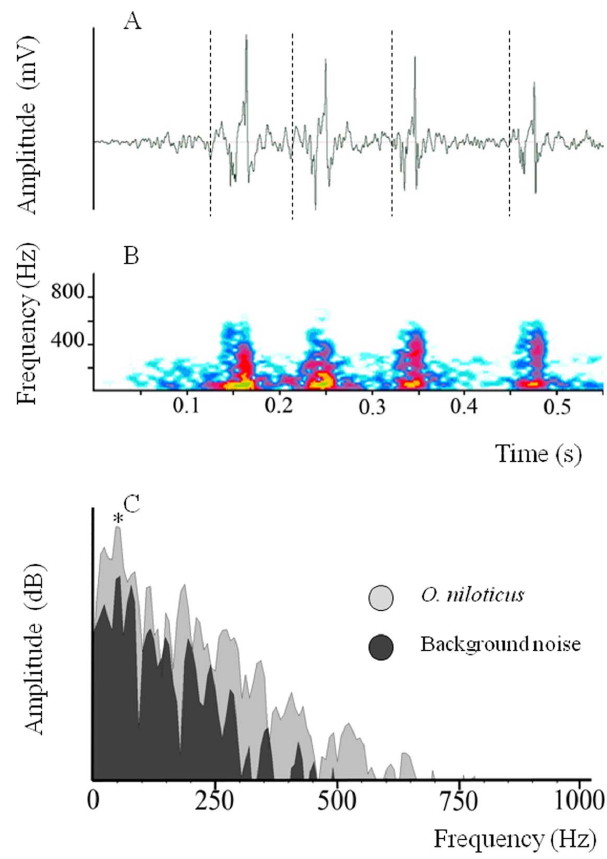
Figure 5. Oscillogram (A) and spectrogram (B) of a sound having four pulses in Oreochromis niloticus female. Frequency spectrum of a pulse (C). ( * )=Main frequency. Spaces between dotted lines correspond to pulse period.